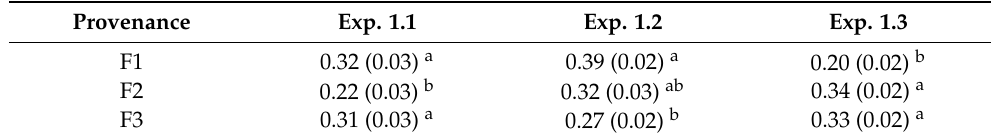
Table 3. The average initiation frequency by provenance with standard error in brackets obtained from Picea pungens initiation experiments.